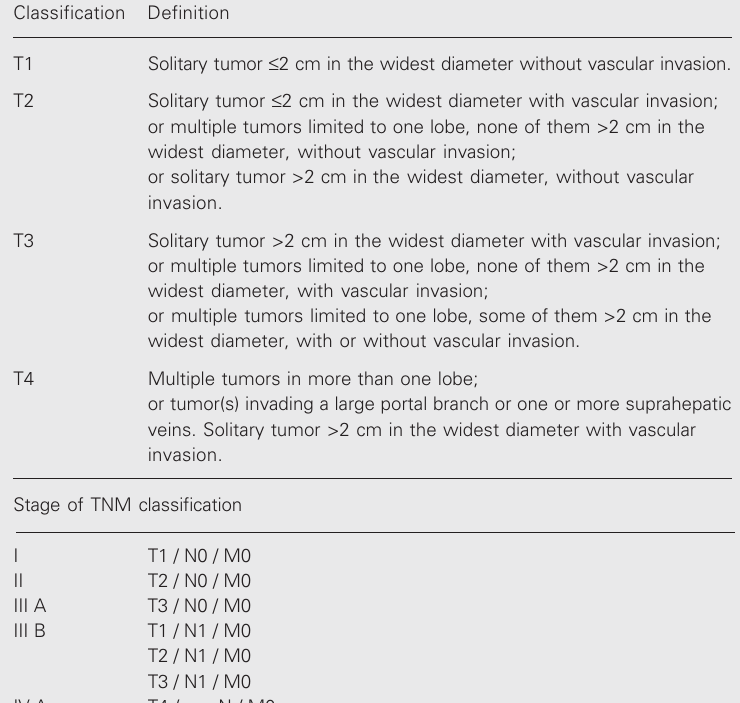
Table 3. TNM classification of hepatocellular carcinomas